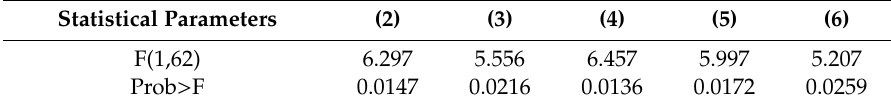
Table A5. Wooldridge test inspection of autocorrelation.